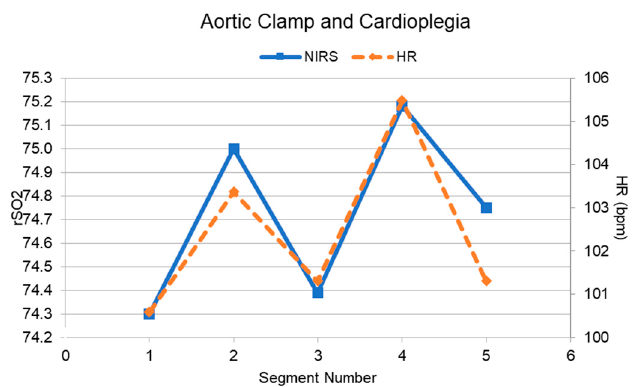
Figure 4. Mean HR and mean rSO 2 curves during the Aortic Clamp and Cardioplegia sub-phase.